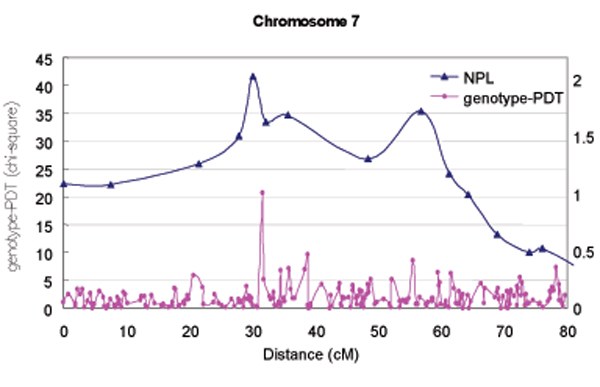
Linkage for microsatellites and association for SNPs on chromosome 7.